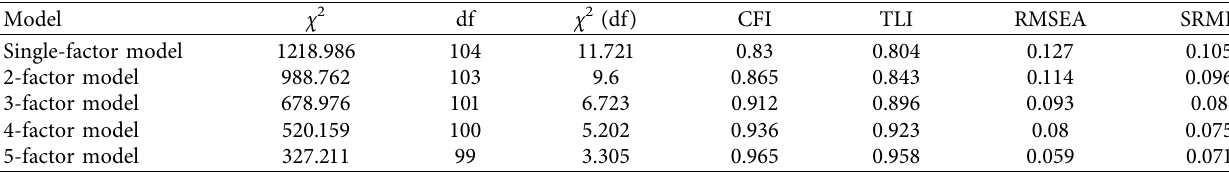
Table 2: Confirmatory factor analysis.